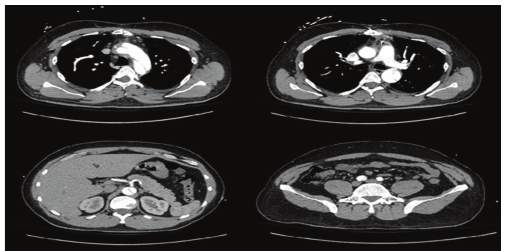
Figure 4: CT scan of second aortic aneurysm and dissection.